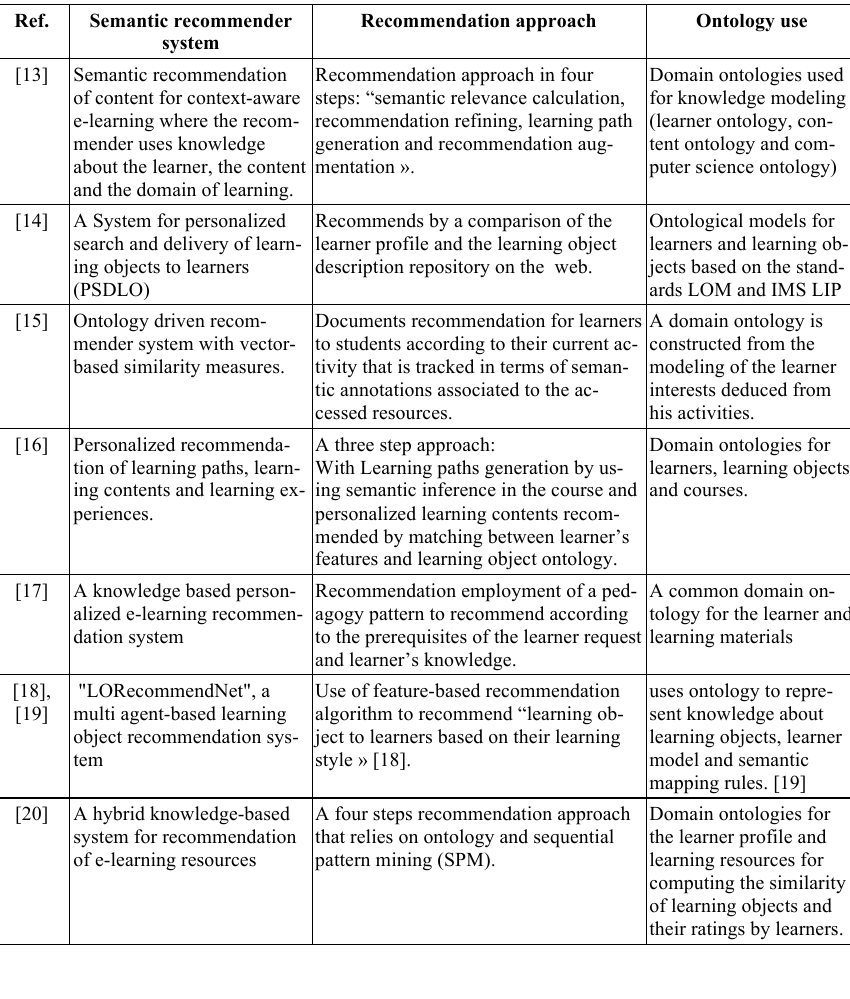
Table 1. Semantic recommender systems and ontology use for distance learning